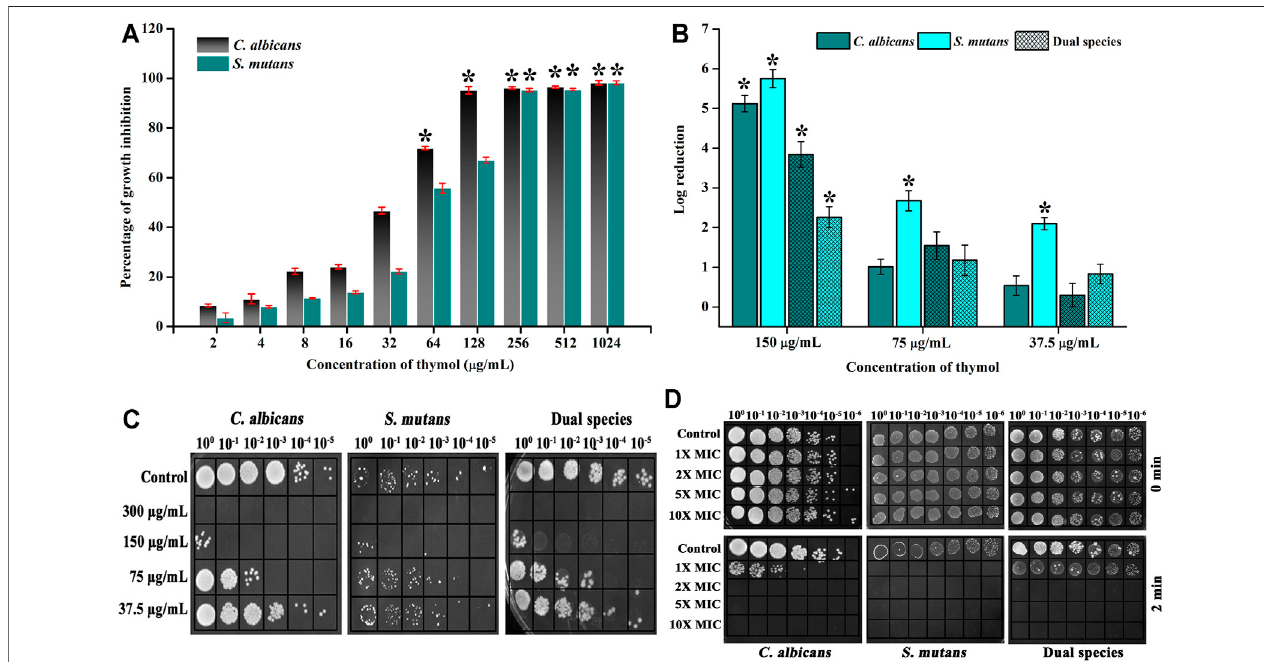
FIGURE1| Impactofthymolonthegrowthofmonoanddualspeciesof C.albicans and S.mutans. (A) Thymolsigni fi cantlyimpairedthegrowthof C.albicans and S.mutans at128and256 μ g/mlconcentrations,respectively. (B) Proliferationofgrowth wascompletelyarrested at300 μ g/mlforsingleanddualspeciesof C.albicans and S. mutans. (B) Log reduction in cfu/ml of pathogens under sub-inhibitory concentrations of thymol. (C) Spot assay con fi rming the complete inhibition of growth at 300 μ g/ml and reduction in microbial load with increasing concentrations. (D) Rapid killing ef fi ciency of thymol. Two minutes exposure of thymol completely inhibited S.mutans at 1XMIC and C. albicans and dualspeciesat 2X MIC.Error barsrepresentstandard deviations fromthemeanand *indicates signi fi cance p < 0.05.